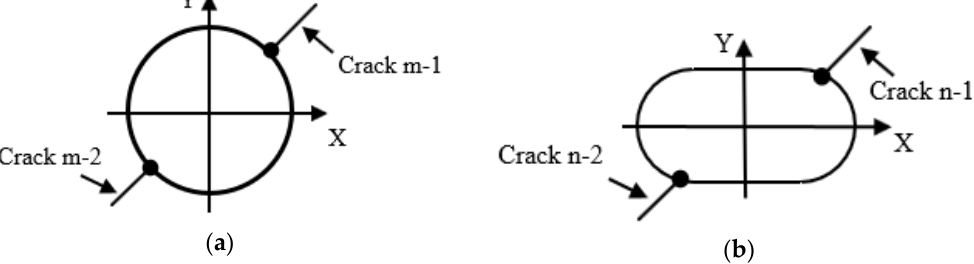
Figure 9. Crack naming method of cruciform specimen. ( a ) Cruciform specimen with circular notch in the central area. ( b ) Cruciform specimen with 0° waist circle hole notch in the central area.